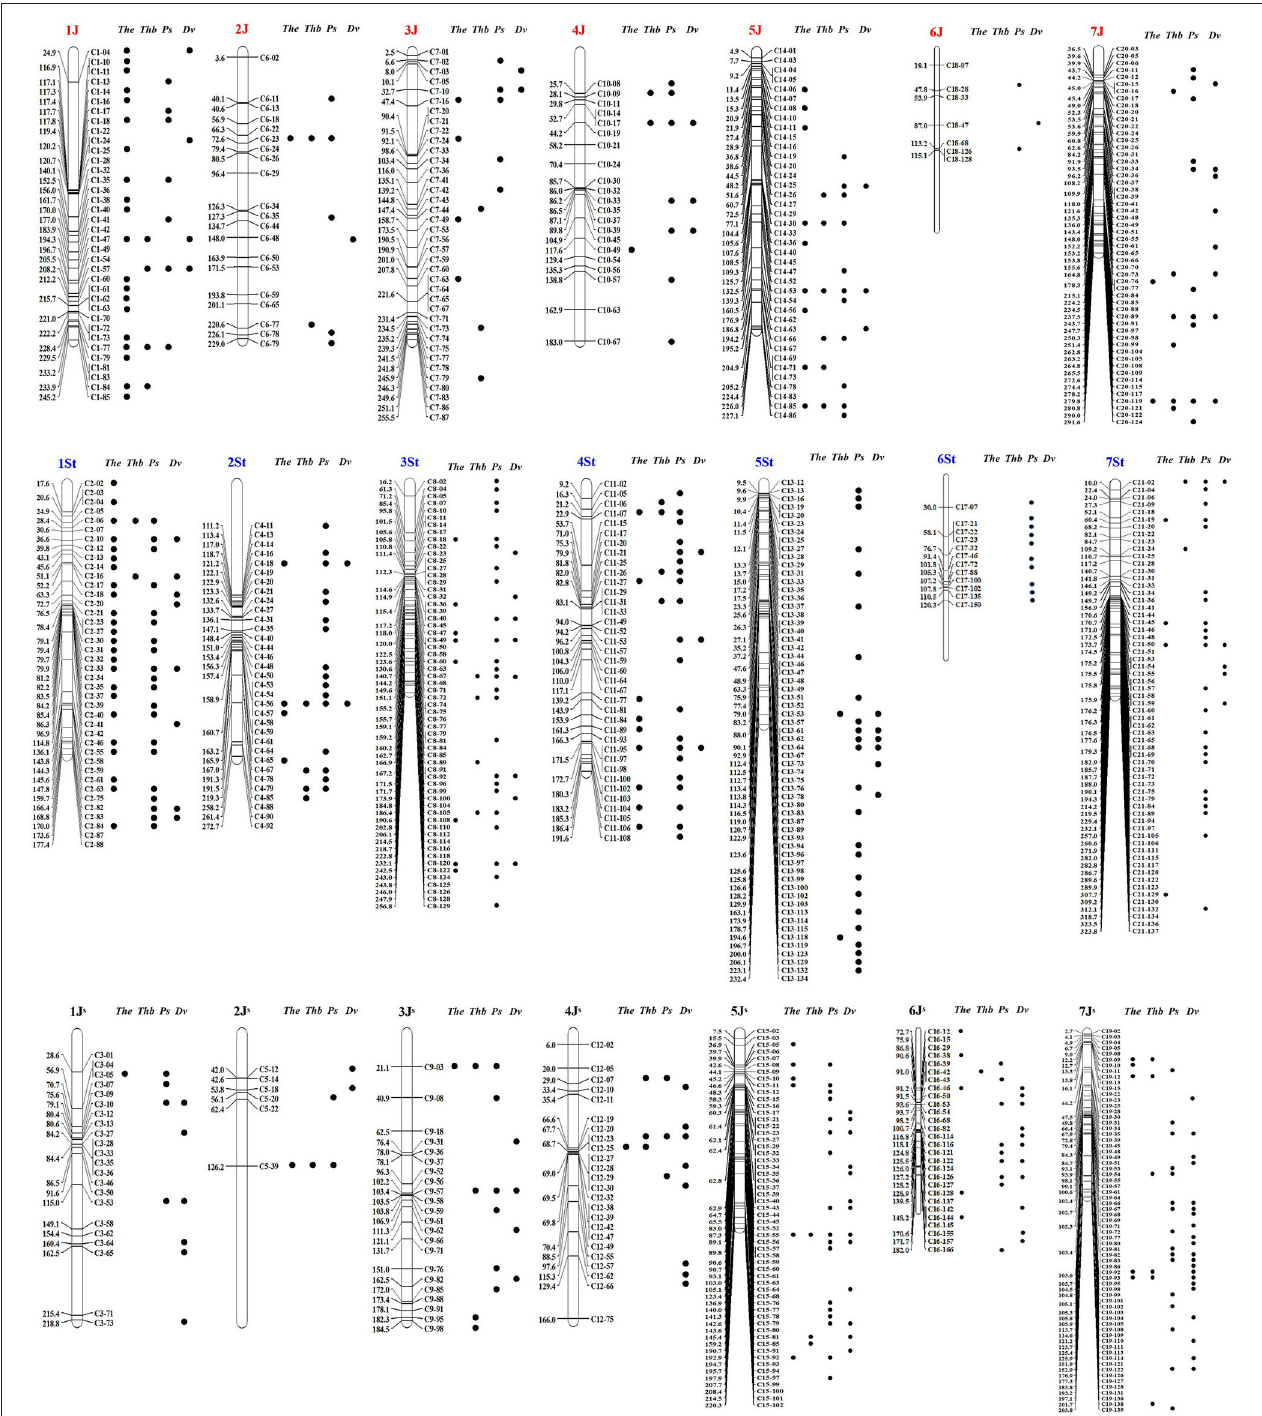
FIGURE 2 | A linkage map of 745 Thi -specific STS markers derived from the Thi -GBS linkage map reported in Kantarski et al. (2017). Black dots next to the markers indicate that these markers have amplification products in Th. elongatum ( The ), Th. bessarabicum ( Thb ), Ps. spicata ( Ps ), and D. villosum ( Dv ).